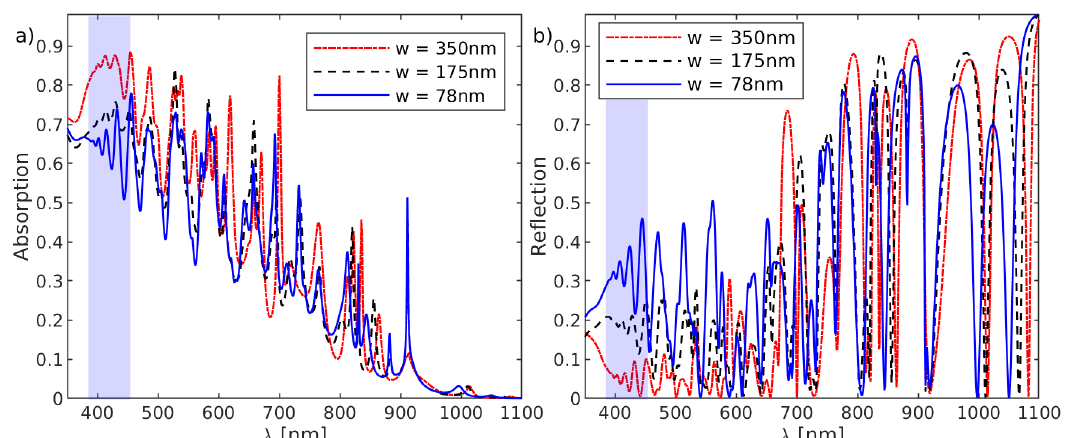
Figure 6. ( a ) simulated spectral response of the active layer’s optical absorption in structures with a periodic double grating and tooth widths of 78 nm (solid blue line), 175 nm (black dashed line) and 22 nm (red dash-dotted line); ( b ) simulated spectral response of the reflected power for all the mentioned tooth widths.